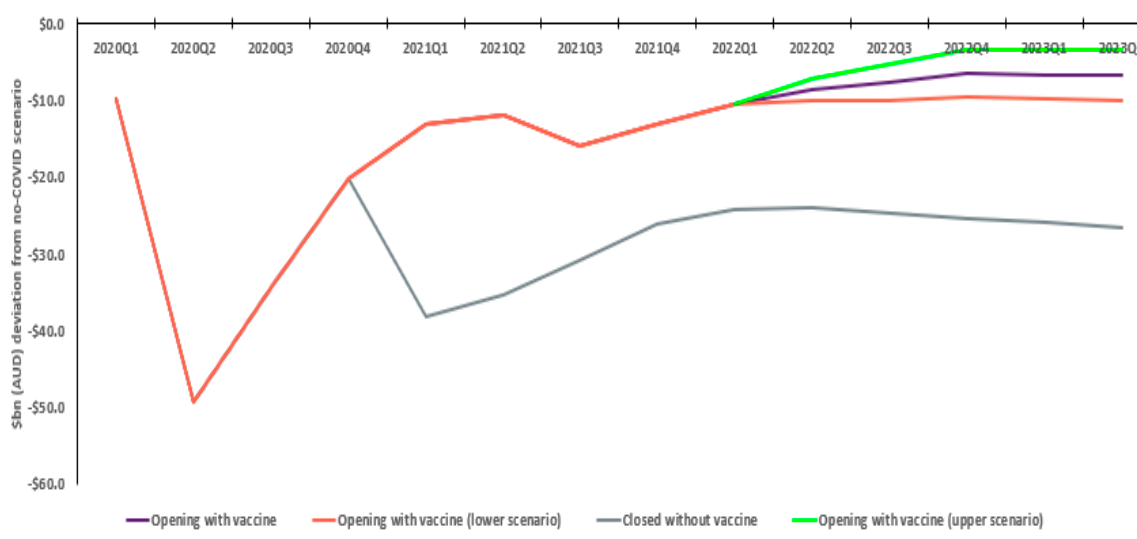
Figure 2. Real National GDP: Estimated deviation from no COVID scenario (AUD bn).